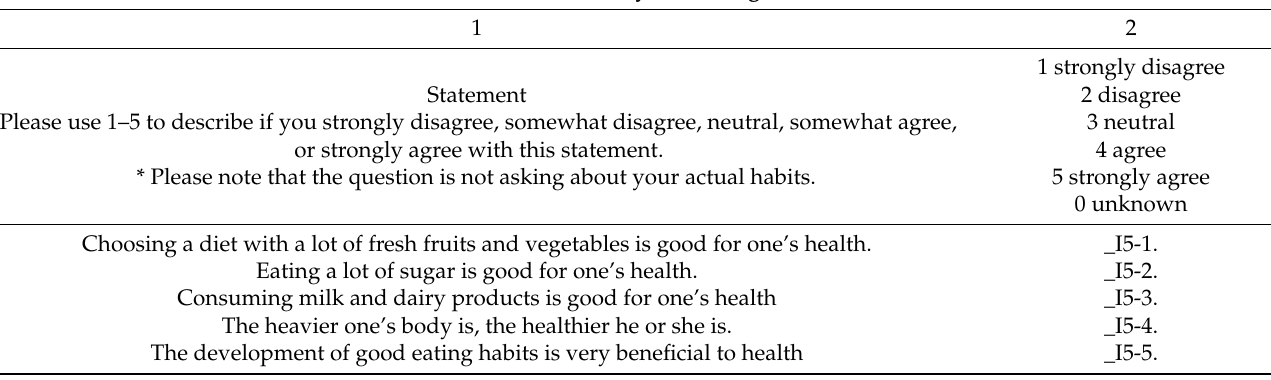
Table A1. The subjective dietary knowledge module of the questionnaire for